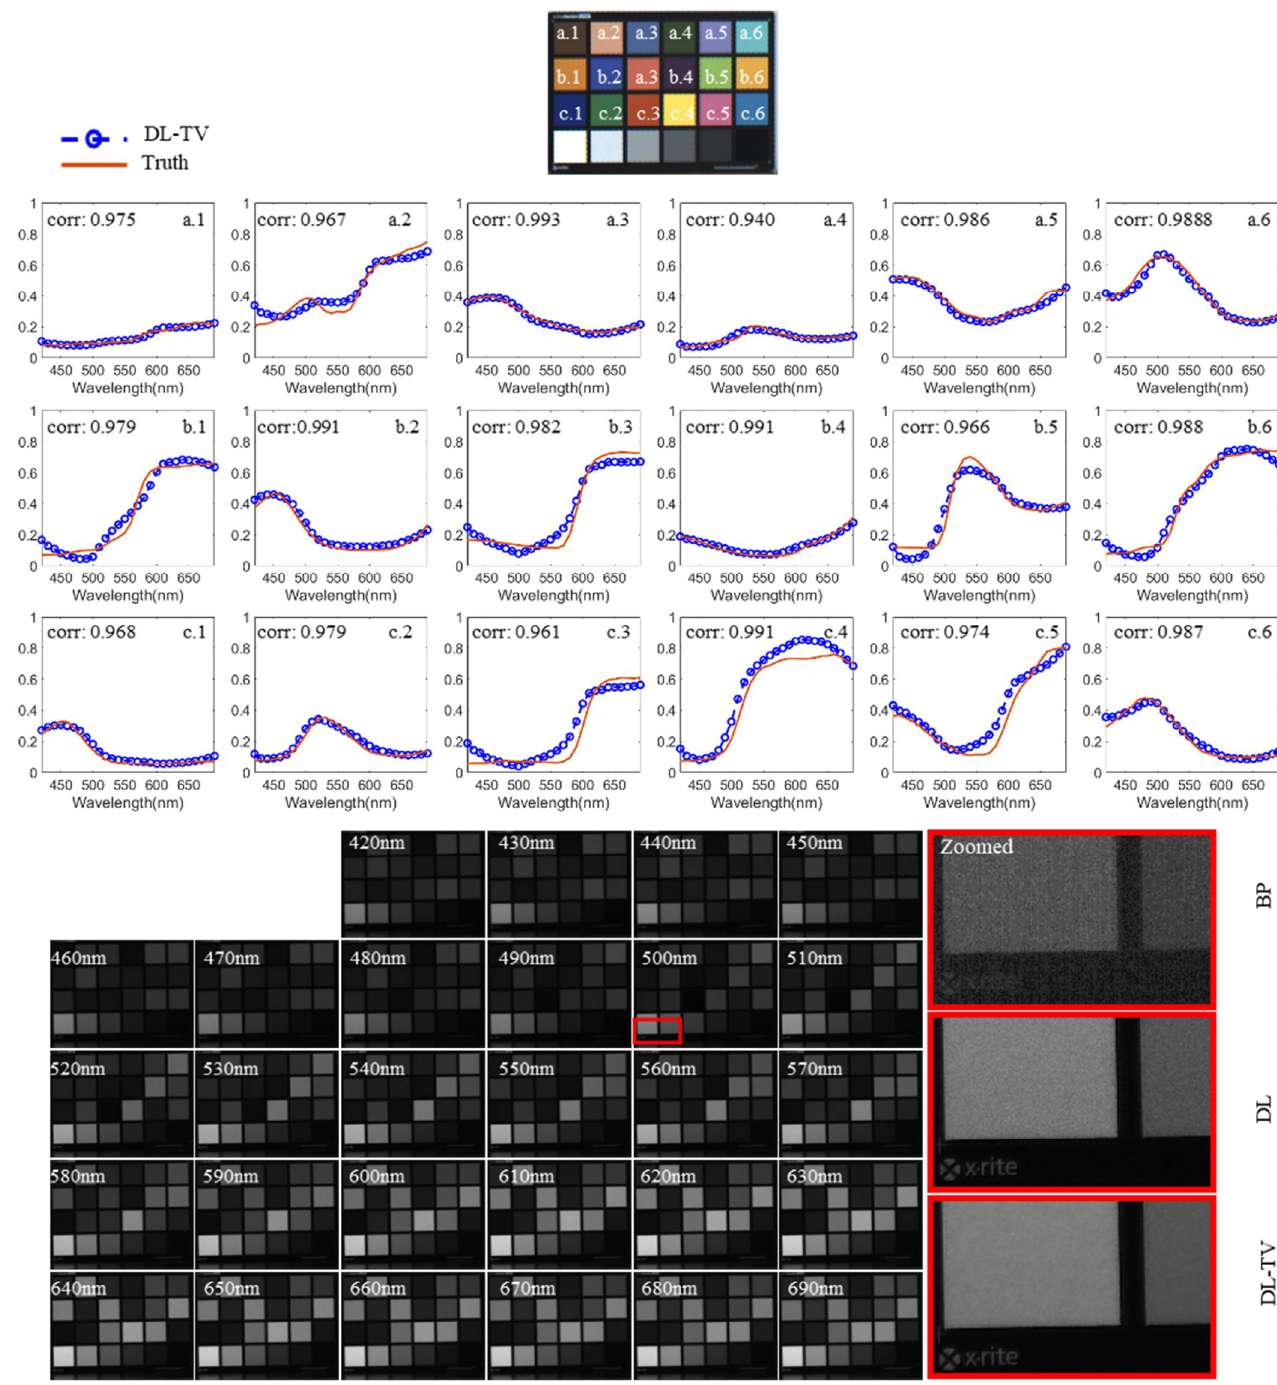
Figure 6. Comparison of the spectra of the 18 color blocks between the reconstructed results and ground truth. The reconstructed MSIs are displayed at the bottom. The spectral range is 420–700 nm. The zoomed-in regions for the 500 nm band are displayed in the right part. BP is the bandpass image.